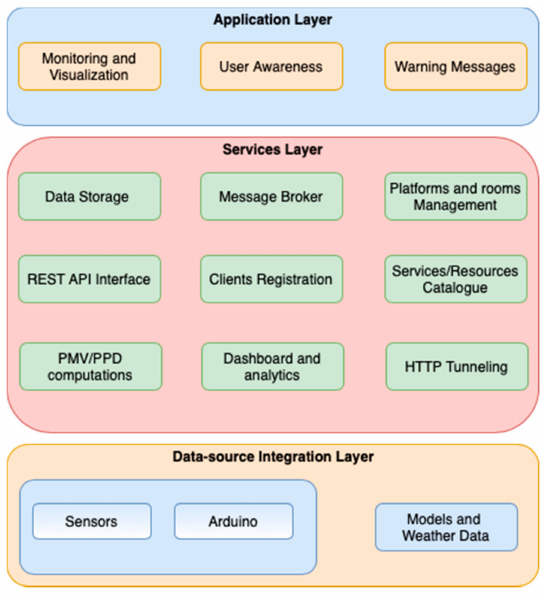
Figure 2. Fundamental layers for system